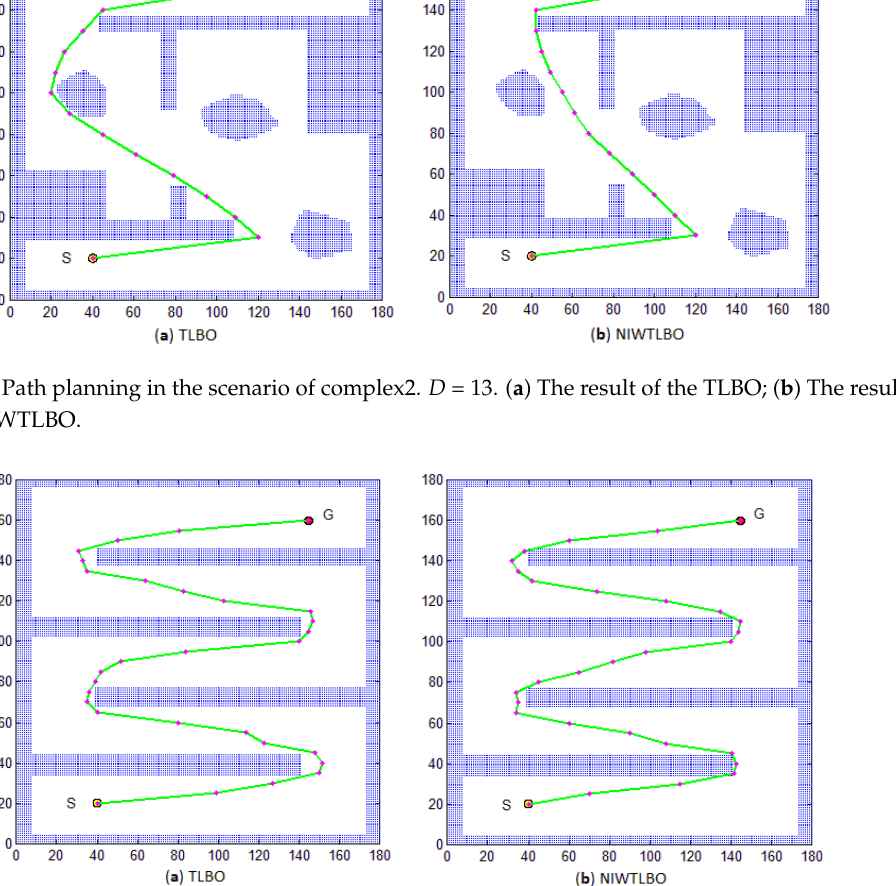
Figure 8. Path planning in the scenario of var_density3. D = 27. ( a ) The result of the TLBO; ( b ) The result of the NIWTLBO. After 10 experiments for each motion planning map, we have achieved the optimal path. From Figures 5 to 8, we can observe that the NIWTLBO method performs better than the basic TLBO on the path planning. Due to the weak ability of exploration and escaping from the local optima, the path obtained by the basic TLBO is not the shortest. The NIWTLBO method improves the population diversity with higher probability of stochastic variations, and it is not easy to trap into the local optima. Therefore, it can achieve the better results. However, the proposed path planning model has some limitations. When the motion planning map only contains the “N” type path, or when the motion planning map is the scenario of rooms, the path planning may fail to find the valid path. We will improve this path planning model and the code of the proposed algorithm to solve such problems in future work. 6. Conclusions TLBO is a new swarm intelligence optimization algorithm that can better solve the continuous space optimization problem. The algorithm is simple and parameter-less with fast convergence speed and high search accuracy. In our recent work, an improved TLBO algorithm called NIWTLBO algorithm is proposed. We apply this algorithm to the global path planning problem of mobile robots in this paper. The simulation experiments show that the algorithm has obvious advantages for the optimization problem of the robot’s global path planning, compared with PSO, ABC, DE and the basic TLBO algorithm. It can obtain the optimal path with fewer generations and shorter path length than the other algorithms. During the early stages of the search in the NIWTLBO, the individuals try to sample diverse zones of the search space. They adjust the movements of trial solutions finely so